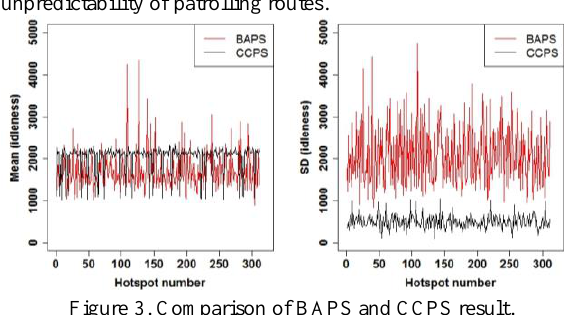
Figure 3. Comparison of BAPS and CCPS result.